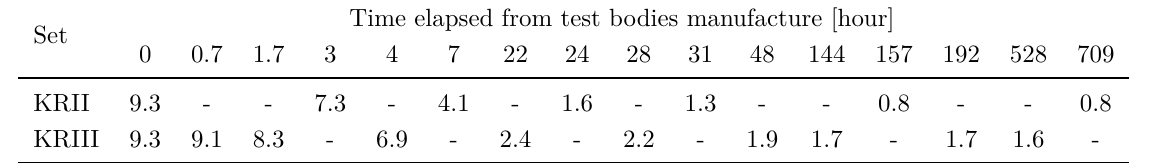
Table 3. Time course of the test bodies average weight moisture content